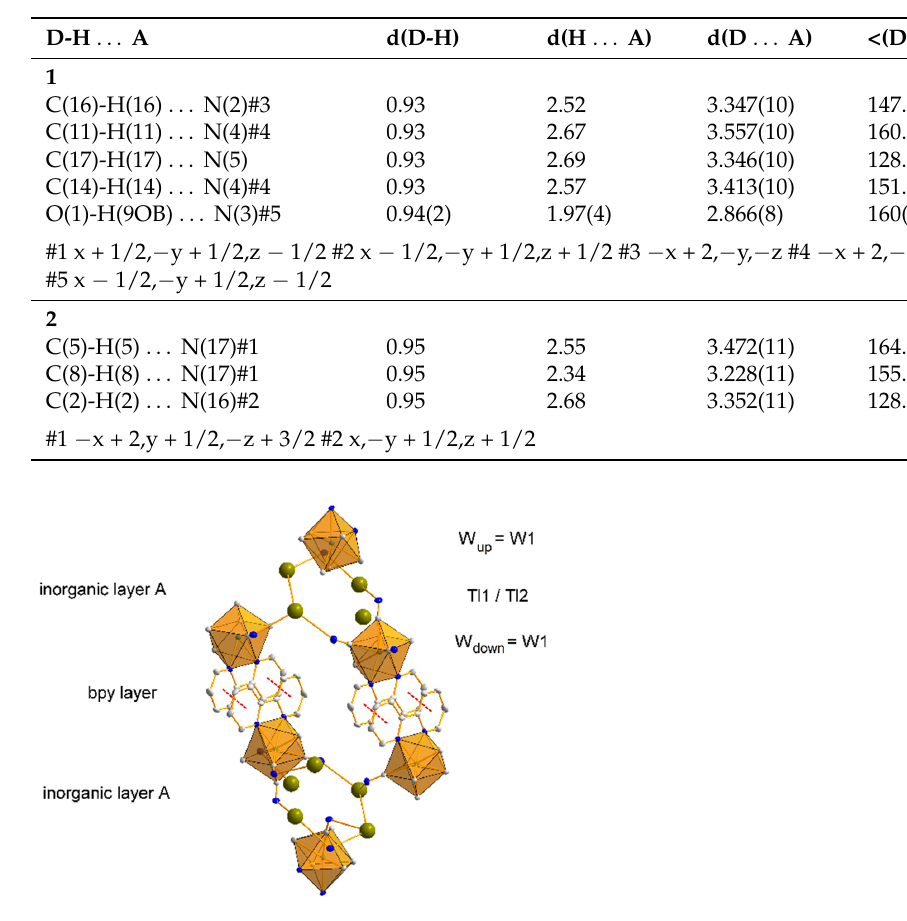
Figure 4. Fragment of structure 1 packing along the [010] direction with the π . . . π interactions (red, dashed lines) between the pyridyl rings of the bpy ligands marked. The figure contains a schematic of the layered structure of 1 , consisting of an inorganic layer A and a bpy layer. The inorganic layer A consists of three sandwiched sublayers, W/Tl/W. Some atoms have been removed for clarity.